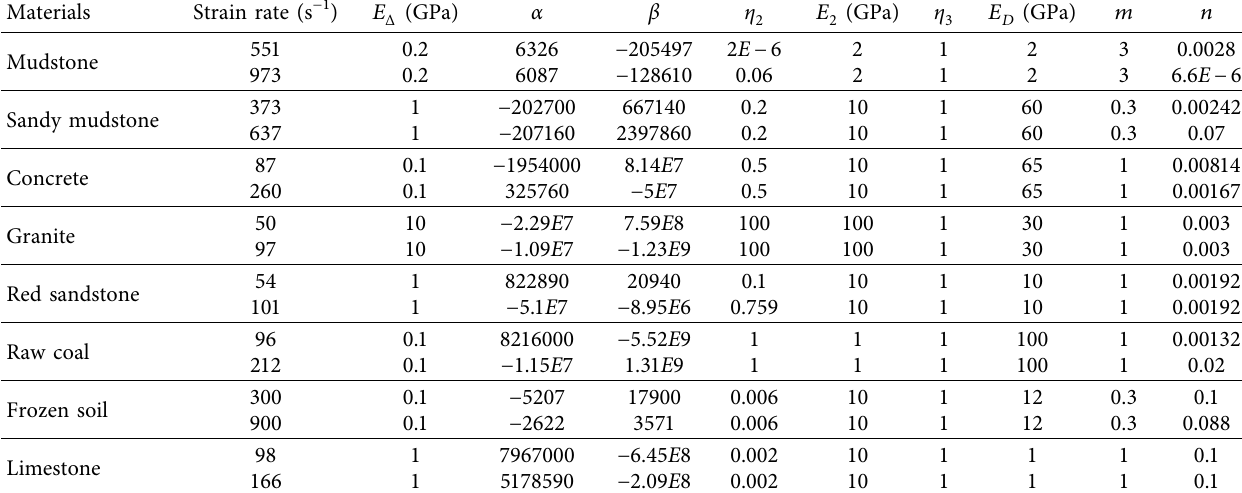
Figure 9: Universal verification of constitutive equation. (a) Mudstone-experimental data cited from literature [9]. (b) Sandy mud-ex- perimental data cited from literature [10]. (c) Concrete-experimental data cited from [12]. (d) Granite-experimental data cited from [12]. (e) Red sandstone-experimental data cited from [28]. (f) Raw coal-experimental data cited from [29]. (g) Frozen soil-experimental data cited from [19]. (h) Limestone-experimental data cited from [30]. Table 3: The fitting parameter values of each